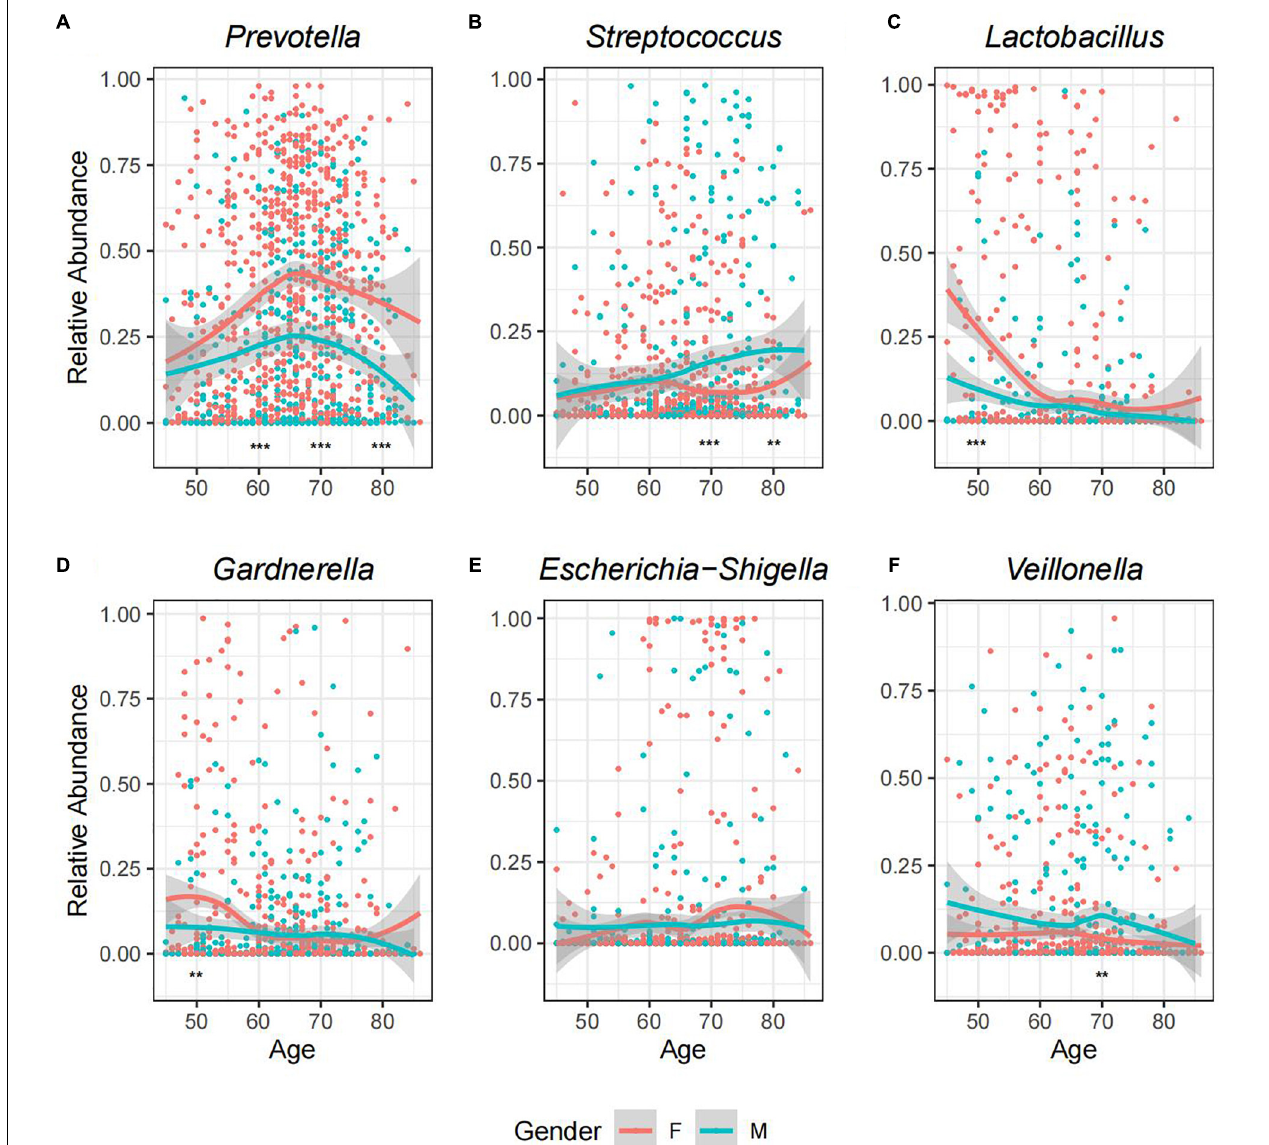
FIGURE 2 | A landscape view of abundance changes in the six most predominant genera with age for both genders. The facets described the MRA of (A) Prevotella , (B) Streptococcus , (C) Lactobacillus , (D) Gardnerella , (E) Escherichia-Shigella , and (F) Veillonella , respectively, along with age for each sample. The smooth curves are formed using the geom_smooth function in R. Relative abundance of each genus was compared between genders at four age stages, and the asterisks indicate the significant level: ** p < 0.05 (Wilcoxon test); *** p <